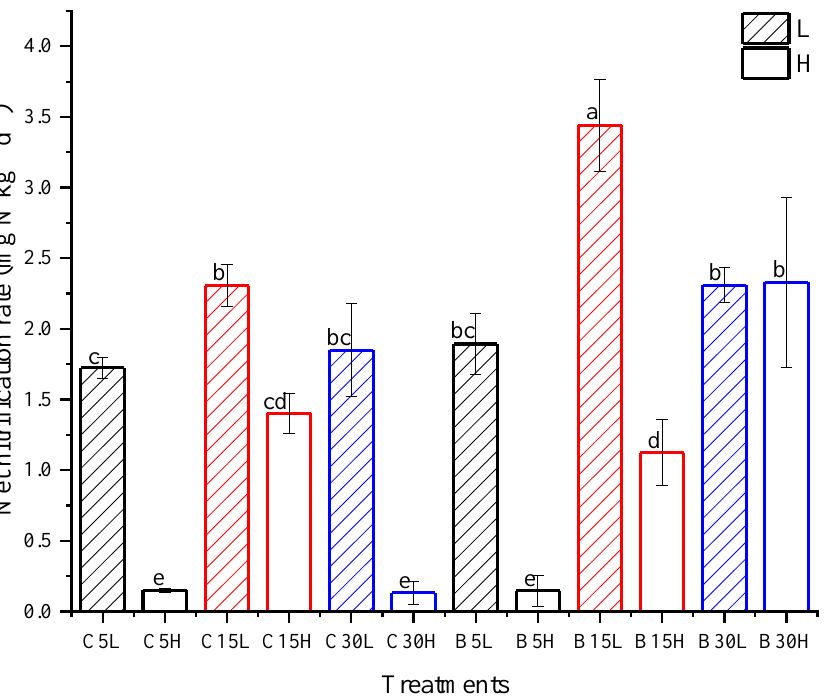
Figure 2. Soil NH 4+ -N and NO 3 − -N concentration during 71-day incubation period; ( a , c ) Changsha and ( b , d ) Baisha; L: 50% WFPS, H: 80% WFPS. 5, 15, and 30 represent soil under 5-y, 15-y, and 30-y tea plantations. Error bars indicate standard deviation.